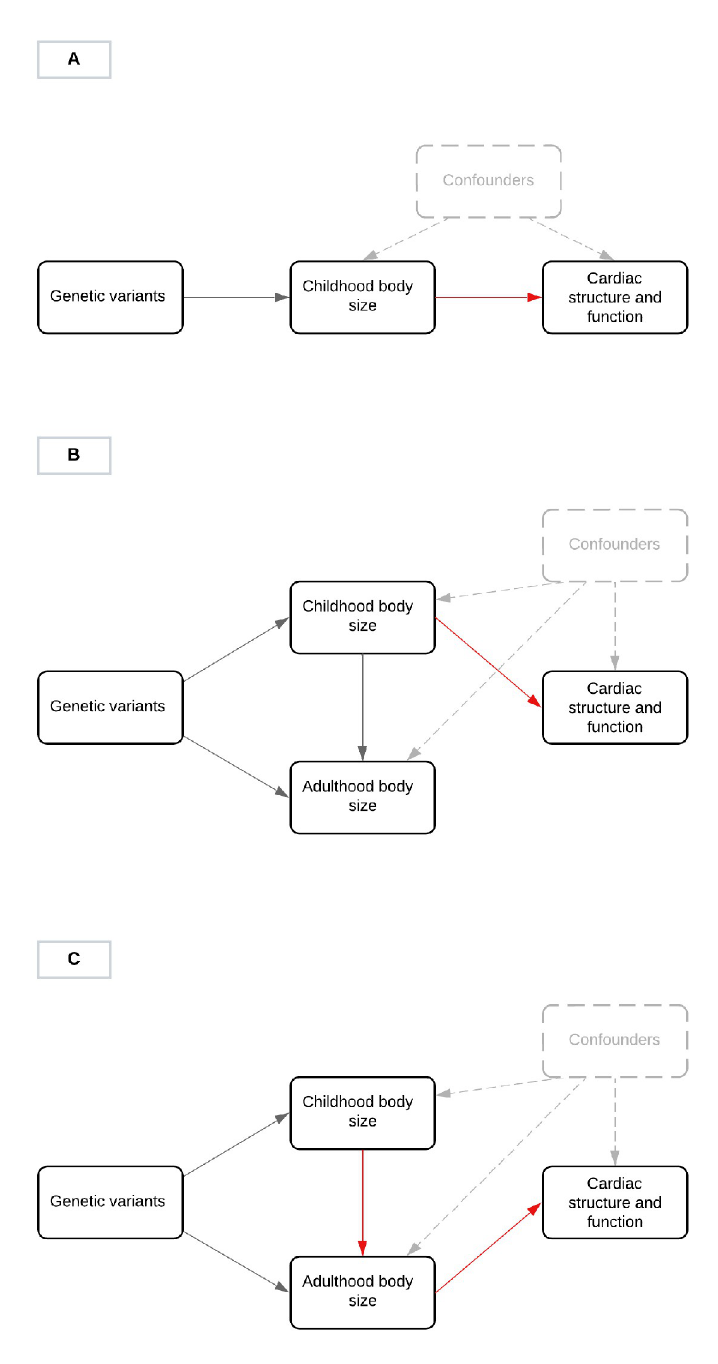
Fig 1. DAGs illustrating the different scenarios through which childhood body size may influence cardiac structure in later life. Fig 1A illustrates the “total” effect of childhood body size on cardiac structure in adulthood. This may be due to a “direct” effect of childhood body size, which is depicted in Fig 1B or an “indirect” effect, mediated through adult body size, which is depicted in Fig 1C . DAG, directed acyclic graph.